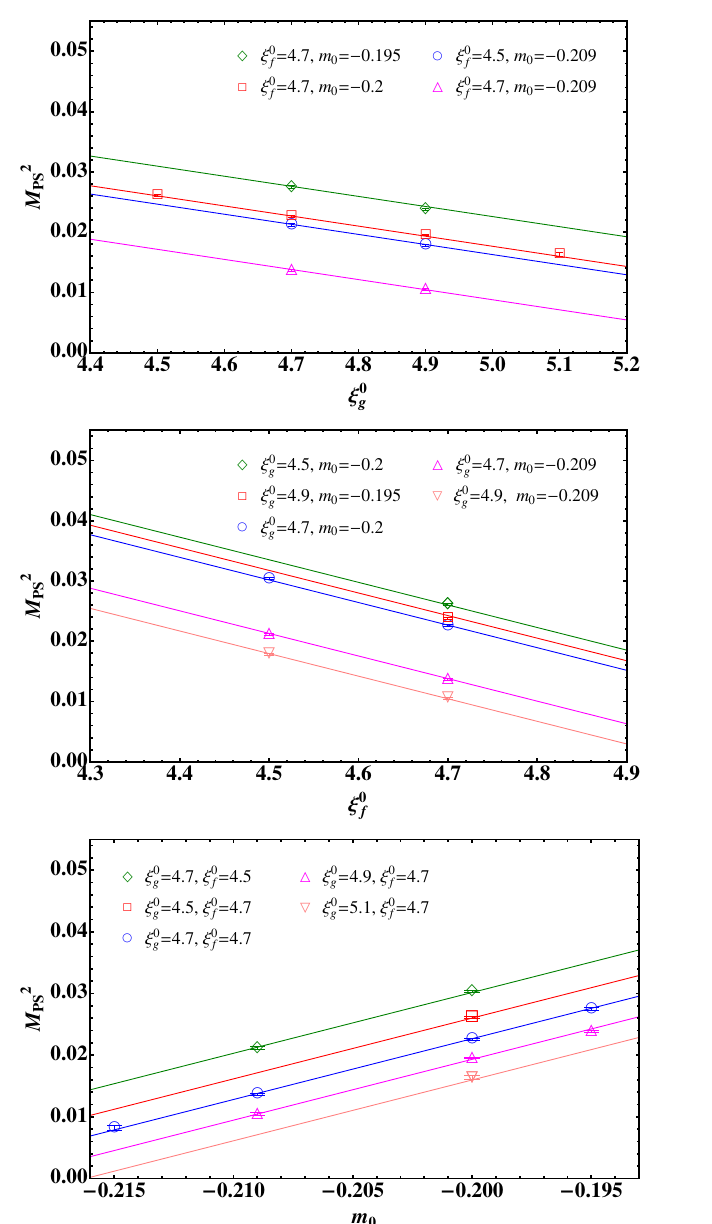
Figure 14 . Squared mass of a pseudoscalar meson M 2 lines denote the (cid:12)t functions in eq. (3.7) where the coe(cid:14)cients are given by eq. (3.13).